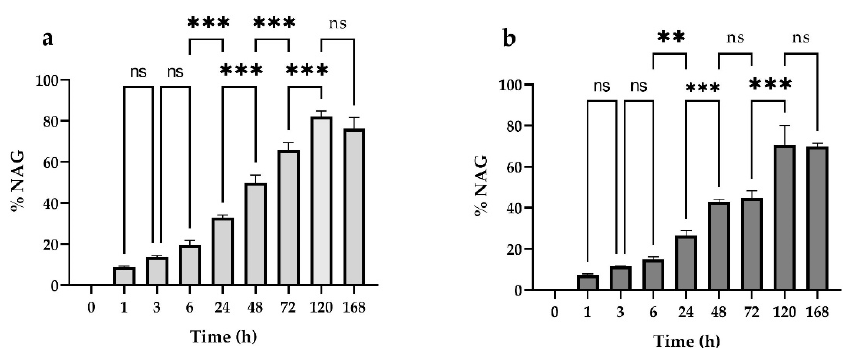
Figure 5. Statistical significance at each time point analyzed compared to the previous one. ( a ) HA 20 mg/mL; ( b ) HA 30 mg/mL. Values of *** p ≤ 0.001 or ** p ≤ 0.01 were considered statistically significant by one-way ANOVA statistical analysis followed by Šid á k’s multiple comparisons as post-test ( n = 2, replicates =